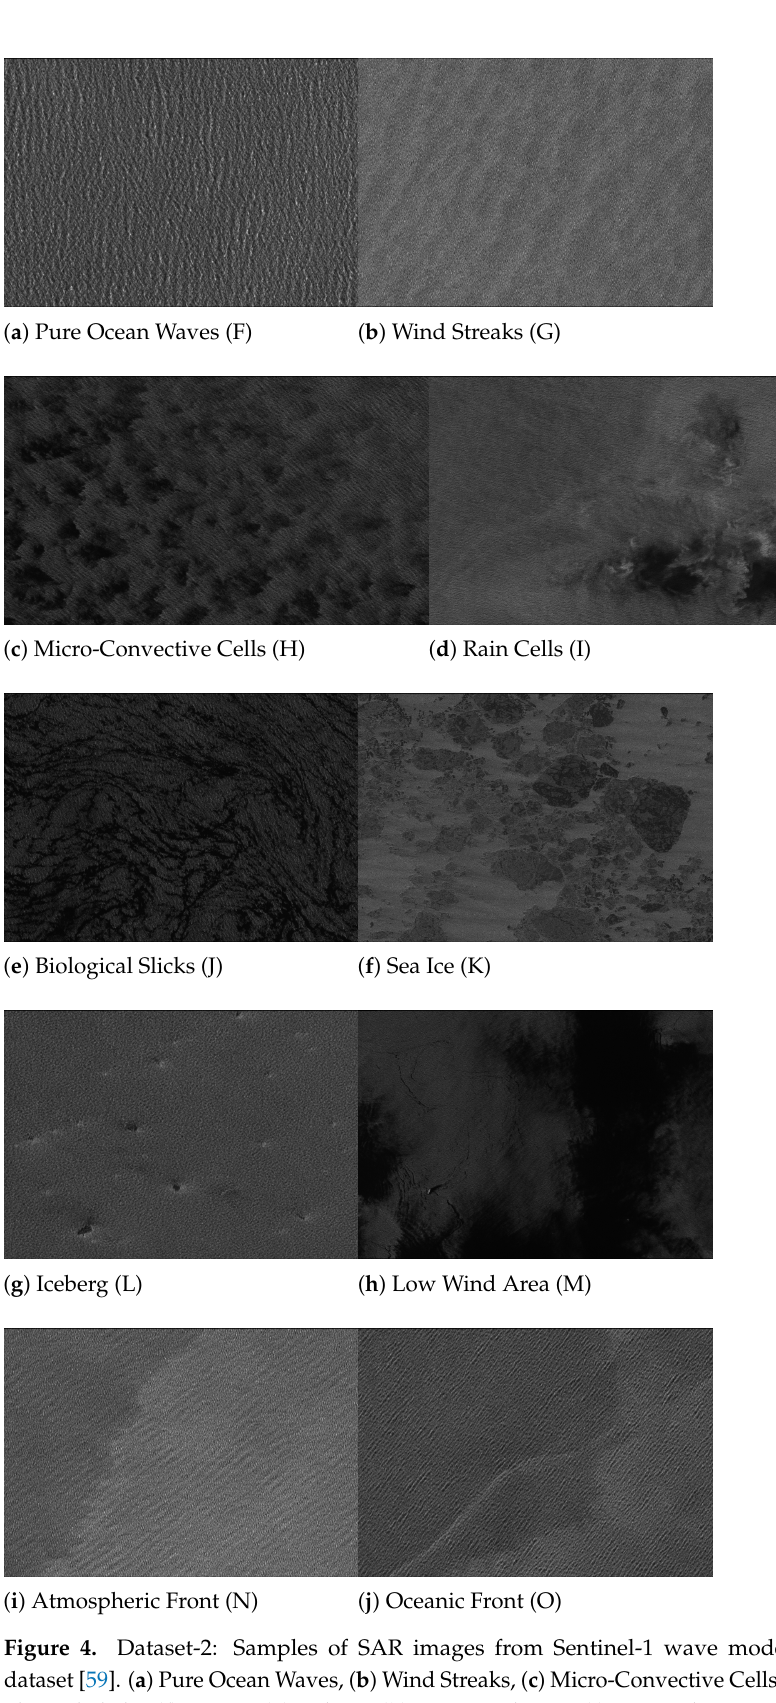
Figure 4. Dataset-2: Samples of SAR images from Sentinel-1 wave mode (TenGeoP-SARwv) dataset [59]. ( a ) Pure Ocean Waves, ( b ) Wind Streaks, ( c ) Micro-Convective Cells, ( d ) Rain Cells, ( e ) Bi- ological Slicks, ( f ) Sea Ice, ( g ) Iceberg, ( h ) Low Wind Area, ( i ) Atmospheric Front, ( j ) Oceanic